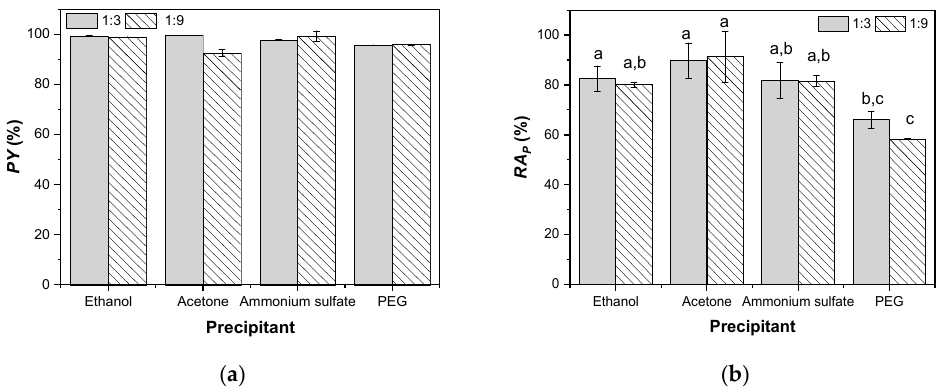
Figure 1. Evaluation of the nature and volume ratio enzyme solution:precipitant in the precipitation of Eversa. ( a ) Activity precipitation yield ( PY , Equation (1)) and ( b ) recovered activity after re-dissolving the precipitates ( RA P , Equation (2)). Precipitation conditions: 4 °C, 150 rpm, 1.5 mg/mL enzyme solution in a 5 mM sodium phosphate buffer, pH 7. Note: Means followed by the same letter are not statistically different by the Tukey test ( p < 0.05). Hydrolytic activities were measured with tributyrin as the substrate (Section 3.2).